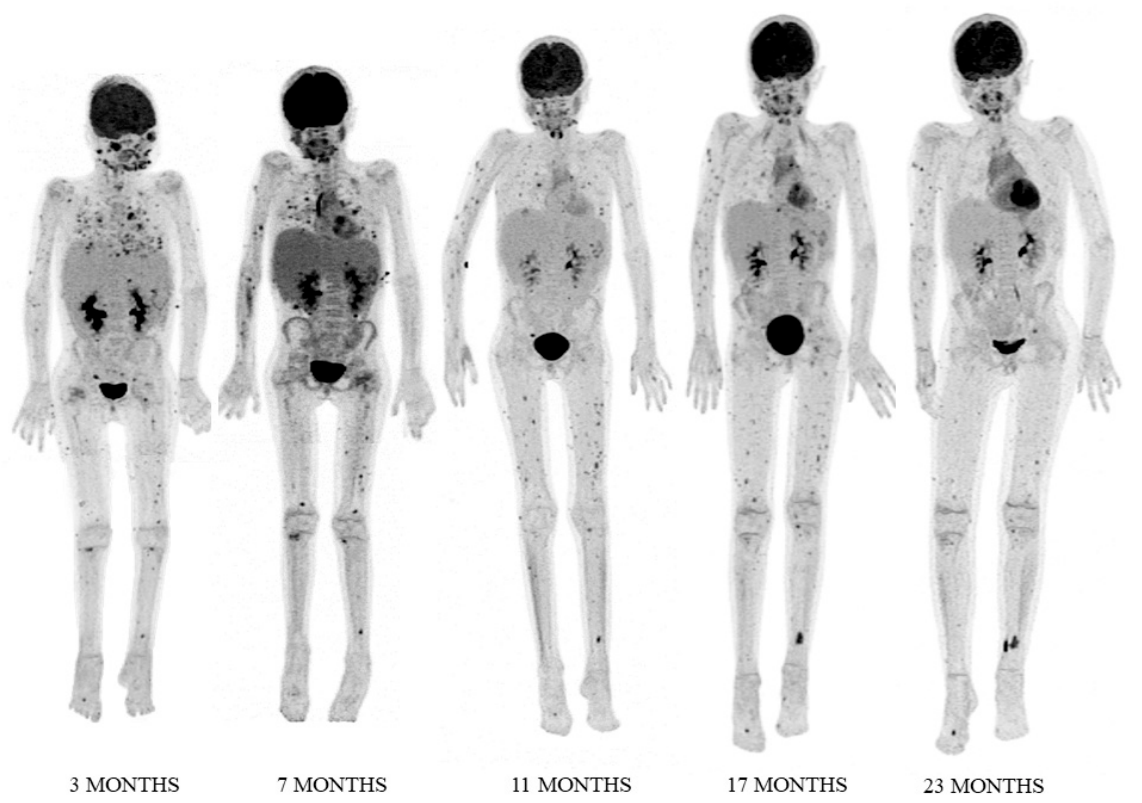
Figure 2. Fluorine-18 fluorodeoxyglucose positron emission tomography ( 18 F-FDG PET) maximum intensity projection (MIP) images at 3, 7, 11, 17, and 23 months after the diagnosis of Aspergillus infection. PET studies showed resolution or reduction of FDG uptake in most fungal lesions located in the paranasal sinuses, left eye, lungs, spleen, bone, and soft tissues (see also Figure 3). A soft tissue lesion in the left leg was the only one showing increased uptake (see also Figure 3; image F).